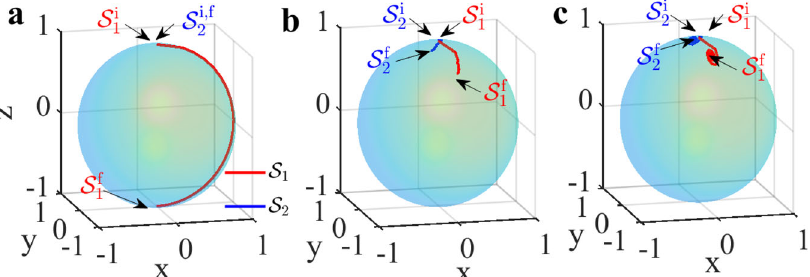
Fig. 7 | Majorana representation. Averaged Majorana trajectories followedby the three-level system for N =25 in the case of a no B -pulse, B -pulses with b equal strengths, and c with randomlychosenstrengths inthe range 0, π ½ (cid:3) . Trajectories of